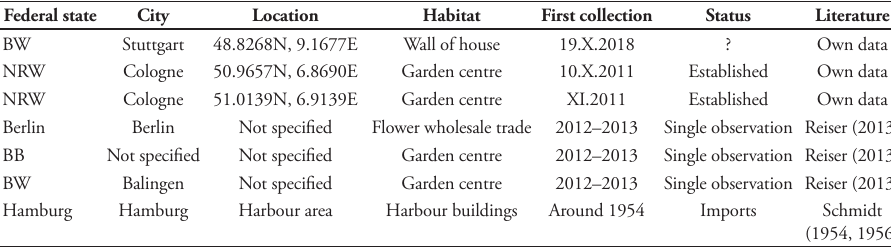
Table 1. Records of Steatoda nobilis in